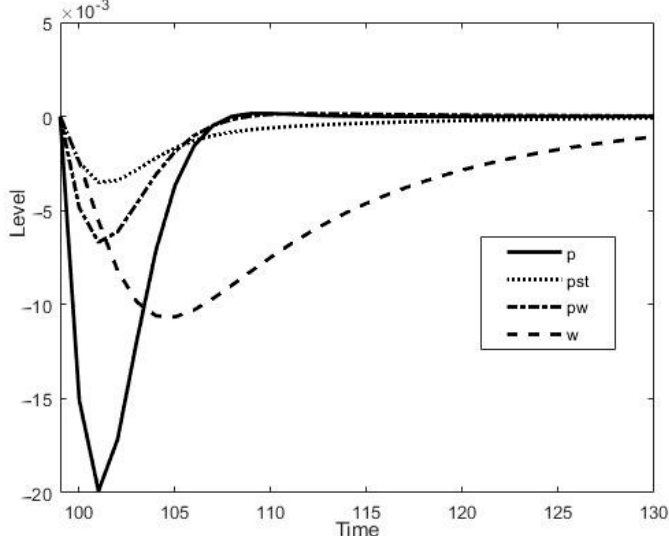
Figure 4. The effect of a positive interest rate shock on the variables of the behavioral model with an imperfect labor market (pw is wage inflation, pst is price inflation, w is the wage gap) and on the price inflation variable p of the model with fixed prices and flexible wages. The shock value is equal to one standard deviation.